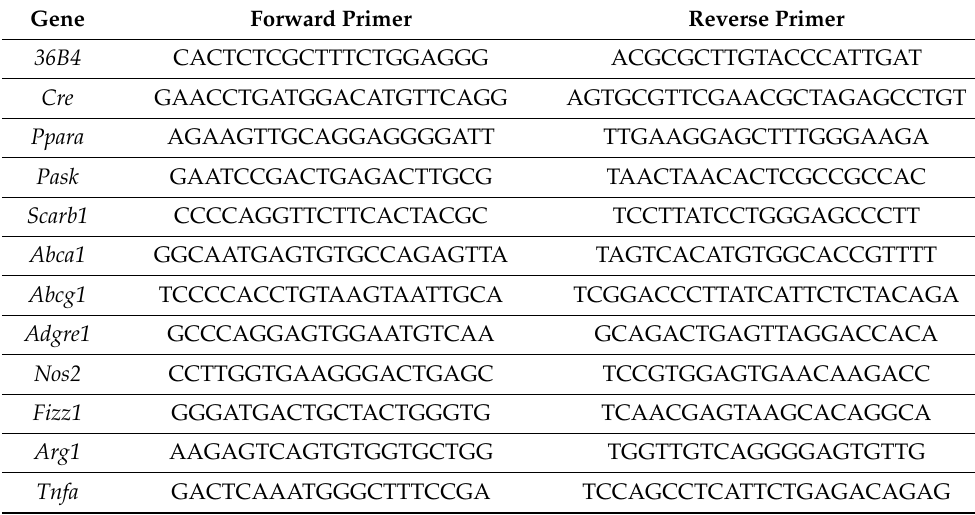
Table 1. Primer sequences used in this